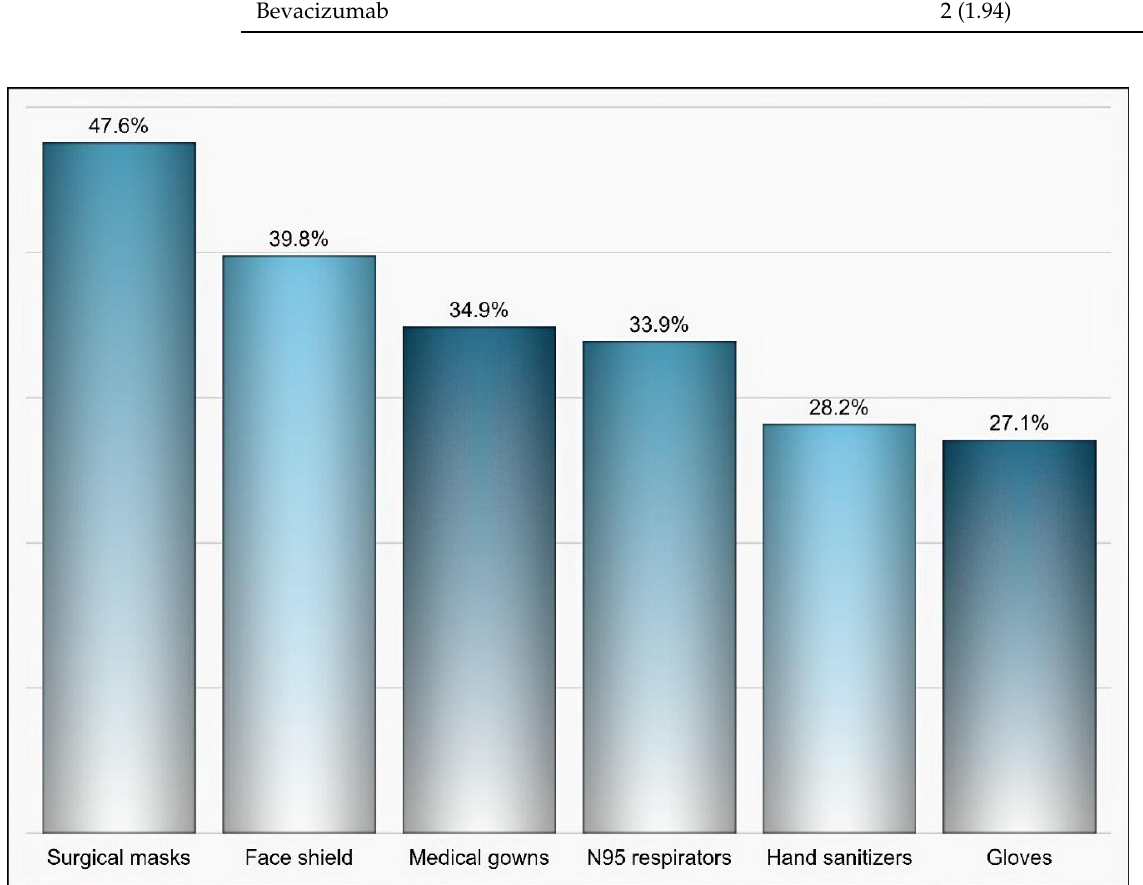
Figure 2. The personal protective equipment (PPE) that was reported to be in shortage based on participants’ responses.